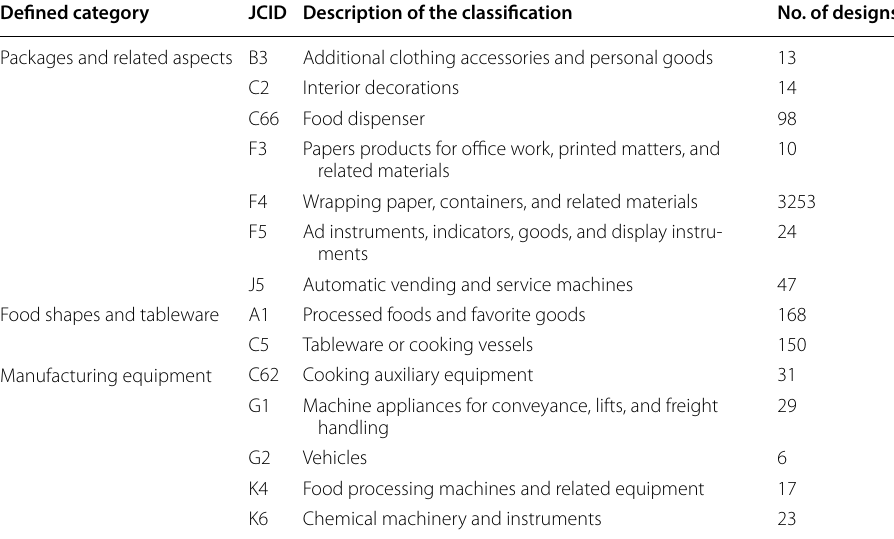
Table 1 Descriptions regarding the classifications of design categories Defined category JCID Description of the classification Packages and related aspects